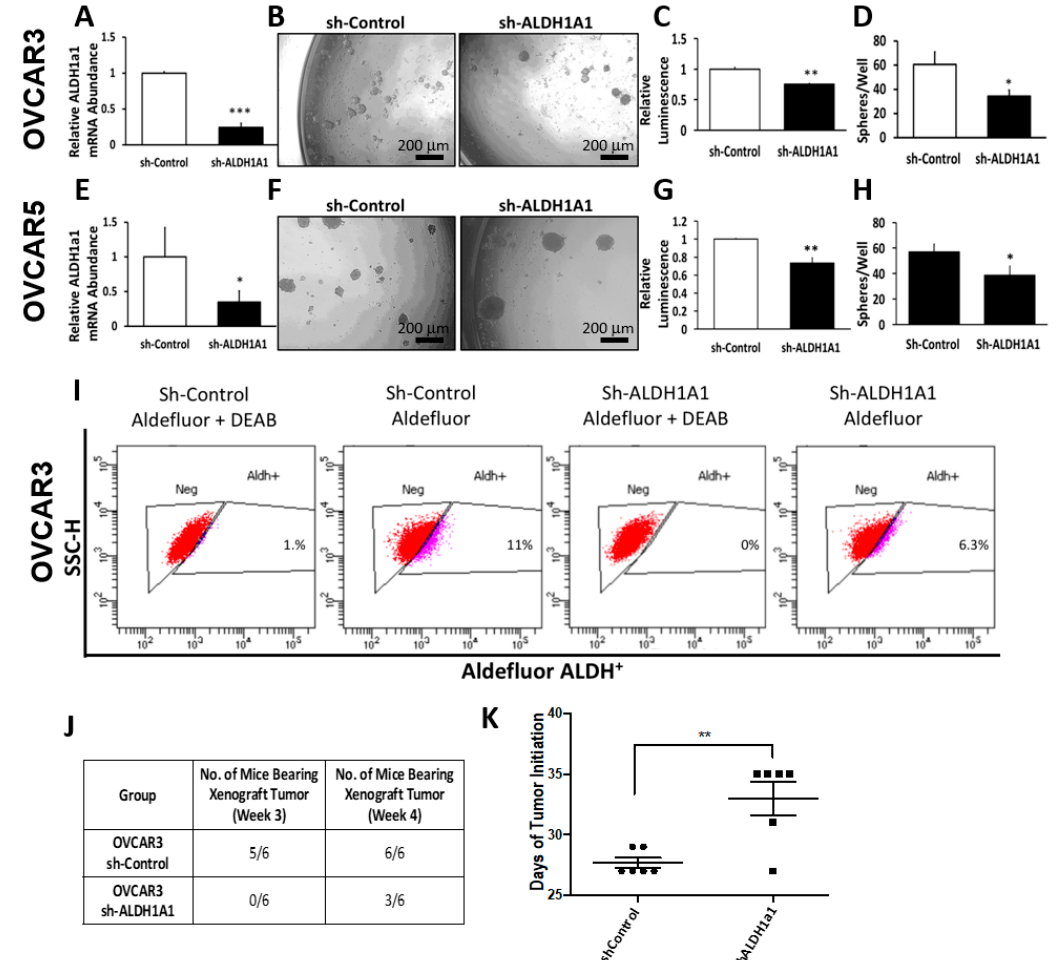
Figure 3. Effects of ALDH1A1 knock down on stemness phenotype. ( A ) OVCAR3 cells were transfected with nontargeting shRNA (Sh-Control) or shRNA targeting ALDH1A1 (sh-ALDH1A1), and ALDH1A1 knockdown was verified by qRT-PCR. ( B , D ) Sphere formation in OVCAR3 cells stably transfected with sh-Control and sh-ALDH1A1 and plated under low attachment conditions for six days. Spheres were photographed (100× magnification, B ); numbers of live cells were assessed by using the Cell-Titer Glo assay ( C ), and the numbers of sphere per well were counted ( D ). ( E ) OVCAR5 cells were transfected with sh-Control or sh-ALDH1A1 and assessed for ALDH1A1 knockdown by qRT-PCR analysis. ( F – H ) OVCAR5 cells were plated under low attachment conditions for six days; spheres were photographed (100× magnification, F ); numbers of live cells were assessed by using the Cell-Titer Glo assay ( G ), and the numbers of sphere per well were counted ( H ). Bars represent averages of triplicate measurements; *** corresponds to p < 0.001; ** corresponds to p < 0.01; * corresponds to p < 0.05. ( I) Percentage of ALDH+ cells in sh-Control or sh-ALDH1A1 transfected OVCAR3 cells. ( J ) OVCAR3 sh-Control and sh-ALDH1A1 were subcutaneously injected into the flanks of nude mice and tumor initiation was assessed; data captures the total number of tumors detectable at week #3 and at week #4. ( K ) Time to tumor initiation measured in days after subcutaneous injection of sh-Control and sh-ALDH1A1 transfected cells in the flanks of nude mice ( n = 6 per group).